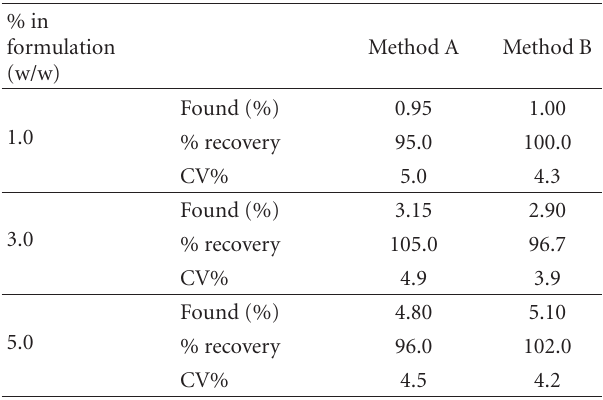
Table 3: Recovery tests ( n = 3), 2 μ Lspot − 1